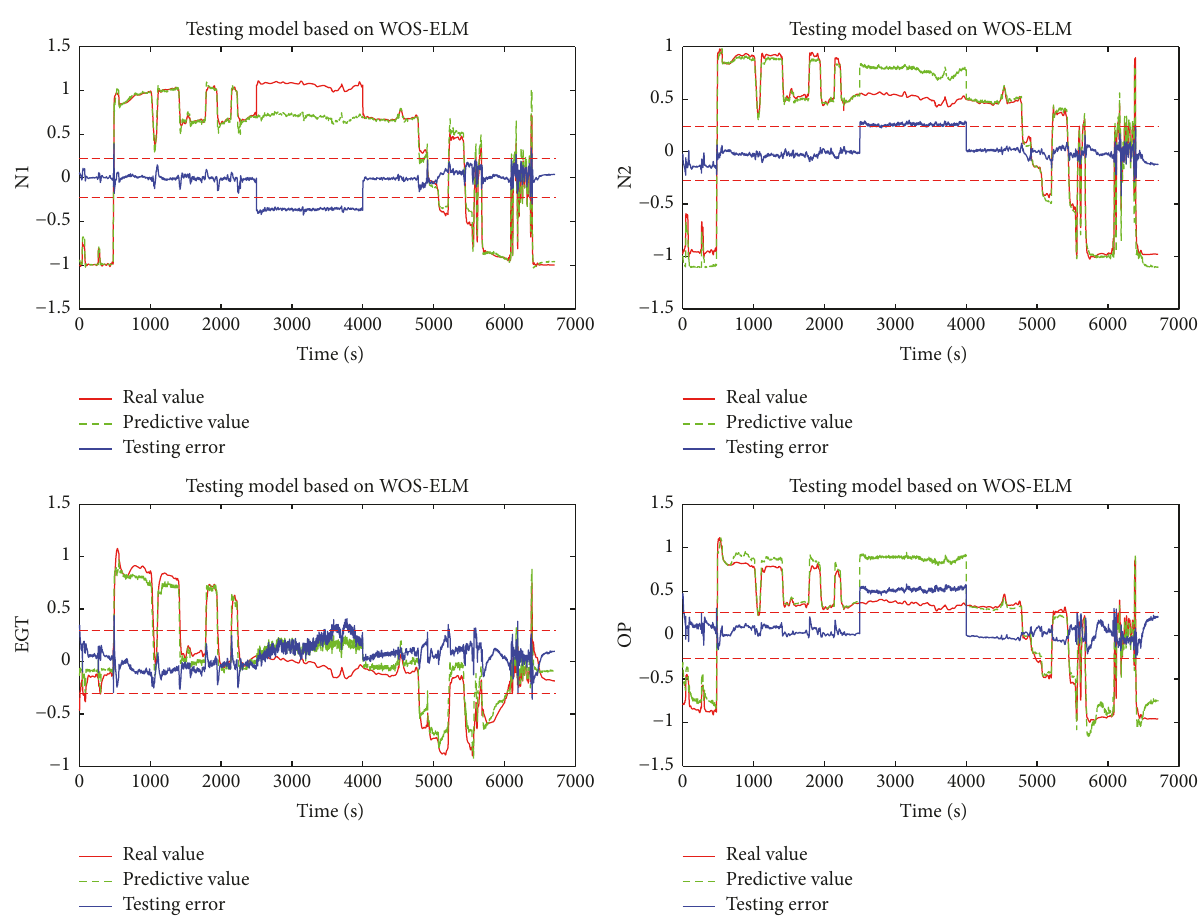
Figure 6: Results of spatial redundancy submodels for step fault of